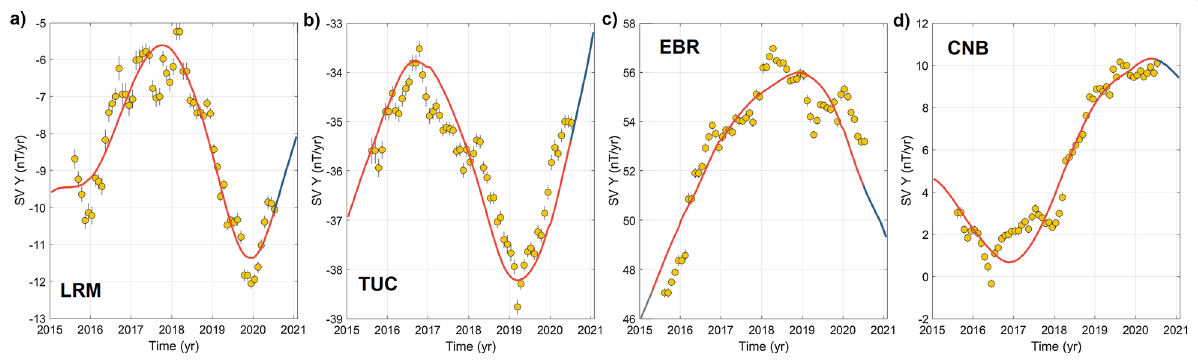
Fig. 2 Yellow dots: SV and its uncertainty (vertical black lines) of the East component Y from Swarm ‑A data relocated at 440 km altitude over the indicated observatory locations (see main text for details). Red/blue curves: SV estimation from CHAOS‑7.7 model. Note that after August 2020 the changes in the curves (blue lines) from CHAOS‑7.7 are likely affected by the model regularization instead of the data (see Sect. 3 for more